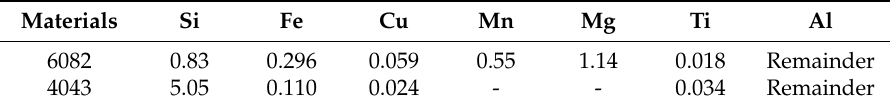
Table 2. Welding parameters.